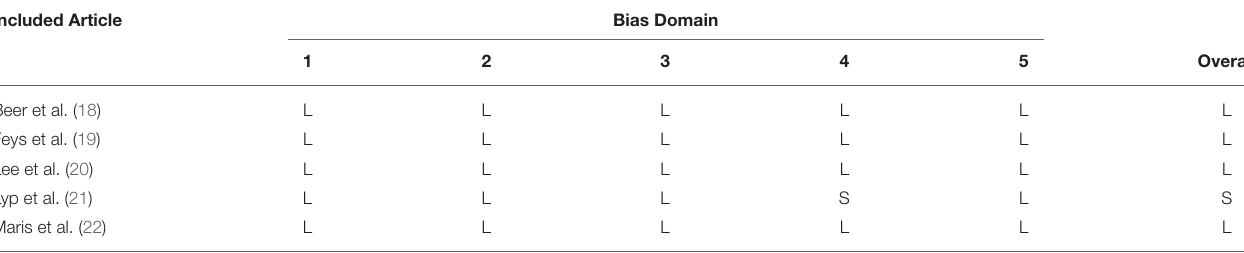
TABLE 2 | Risk of bias assessment using Cochrane Handbook for Systematic Reviews of